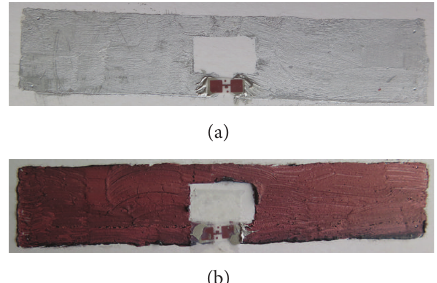
Figure4:(a)Sample10,asilverantennaoncardboardsubstrate,and (b) Sample 15, a copper antenna on cardboard substrate.